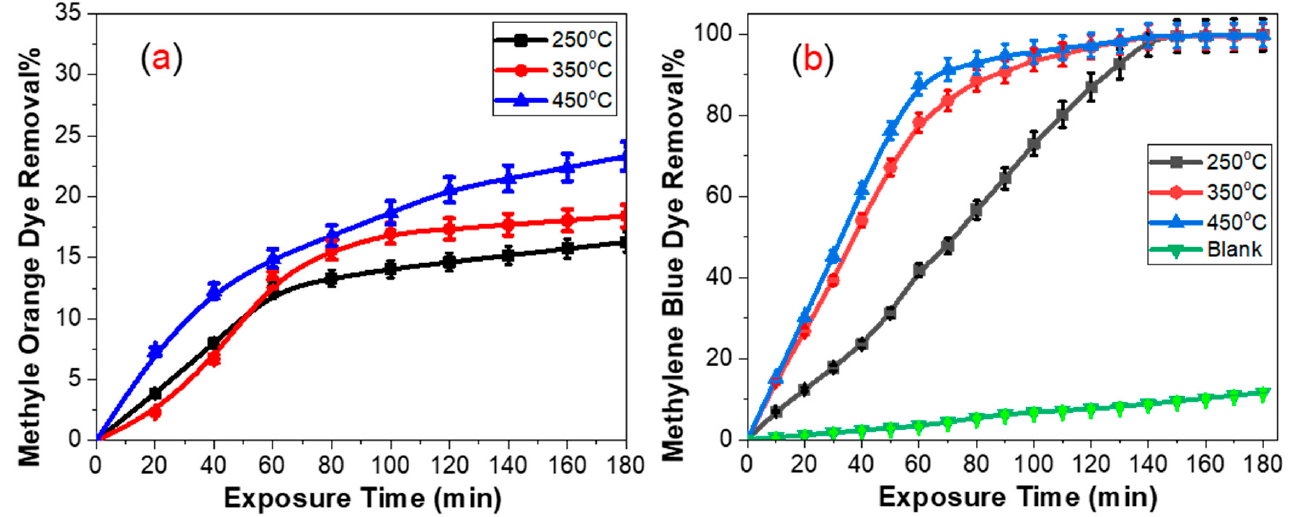
Figure 5. Photocatalytic activity of the as-deposited films toward ( a ) MO and ( b ) MB.